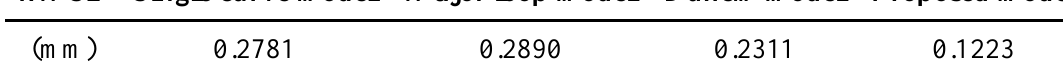
Table 2. RMS errors of the tracking